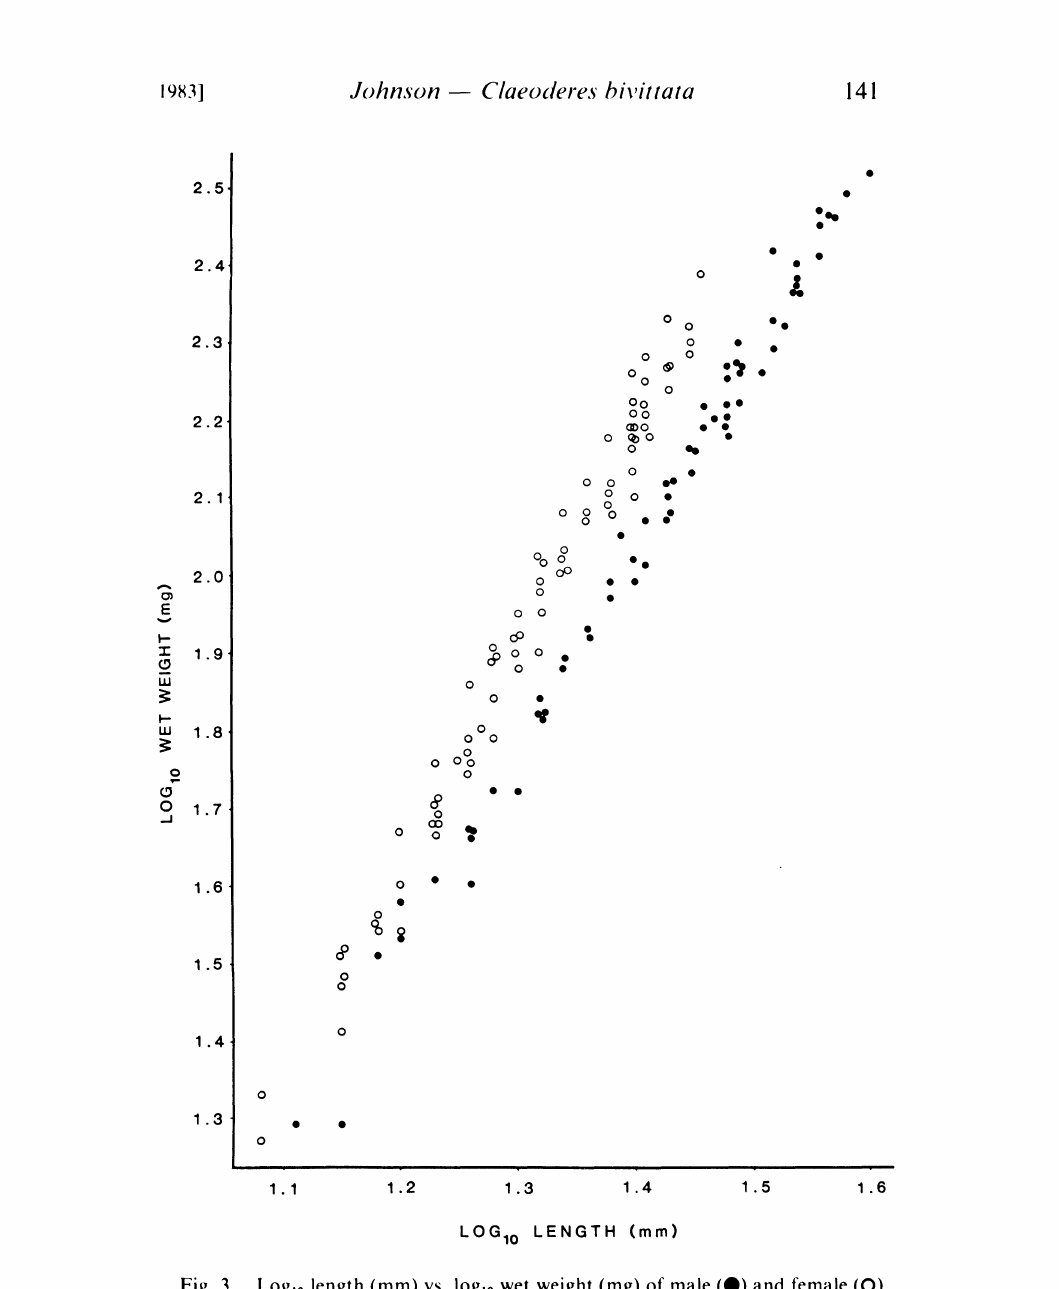
Fig. 3. Log,o length (mm) vs. iog,o wet weight (mg) of male (O) and female (O) Claeoderes hivittata. For males, logo(weight, mg)=-!.53 + 2.54 log,o (length, mm). For females, log,o (weight, mg) -I.78 + 2.83 logo (length,